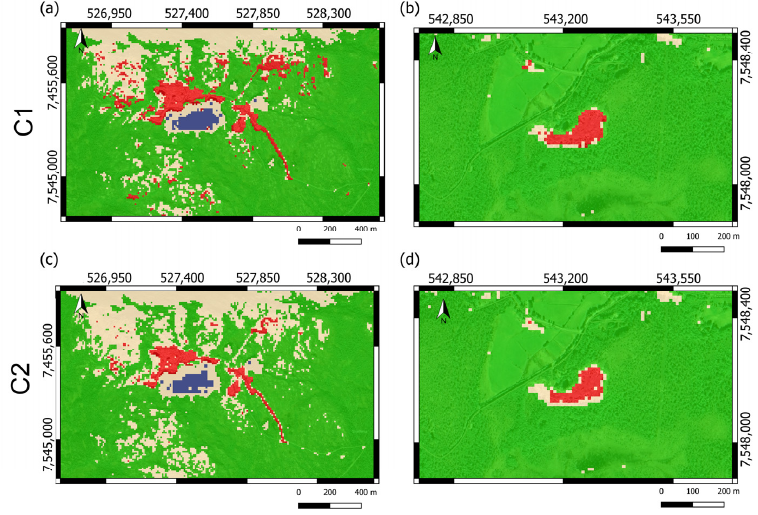
Figure 19. RF classifier for C1 and C2 models. Pegmatites are classified as red colour, granite as beige, water as blue, and vegetation as green ( a ) C1 model classification for Håkonhals mine. ( b ) C1 model classification for Jennyhaugen mine. ( c ) C2 model classification for Håkonhals mine. ( d ) C2 model classification for Jennyhaugen mine.